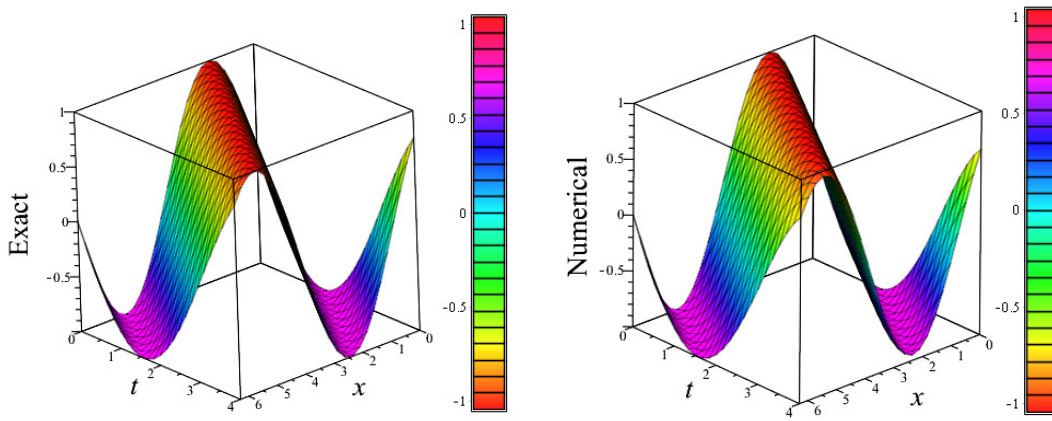
Figure 3. 3D plots of exact solution and approximate solution (using LADM, HPM, RDTM), vs. x vs. t , for numerical experiment